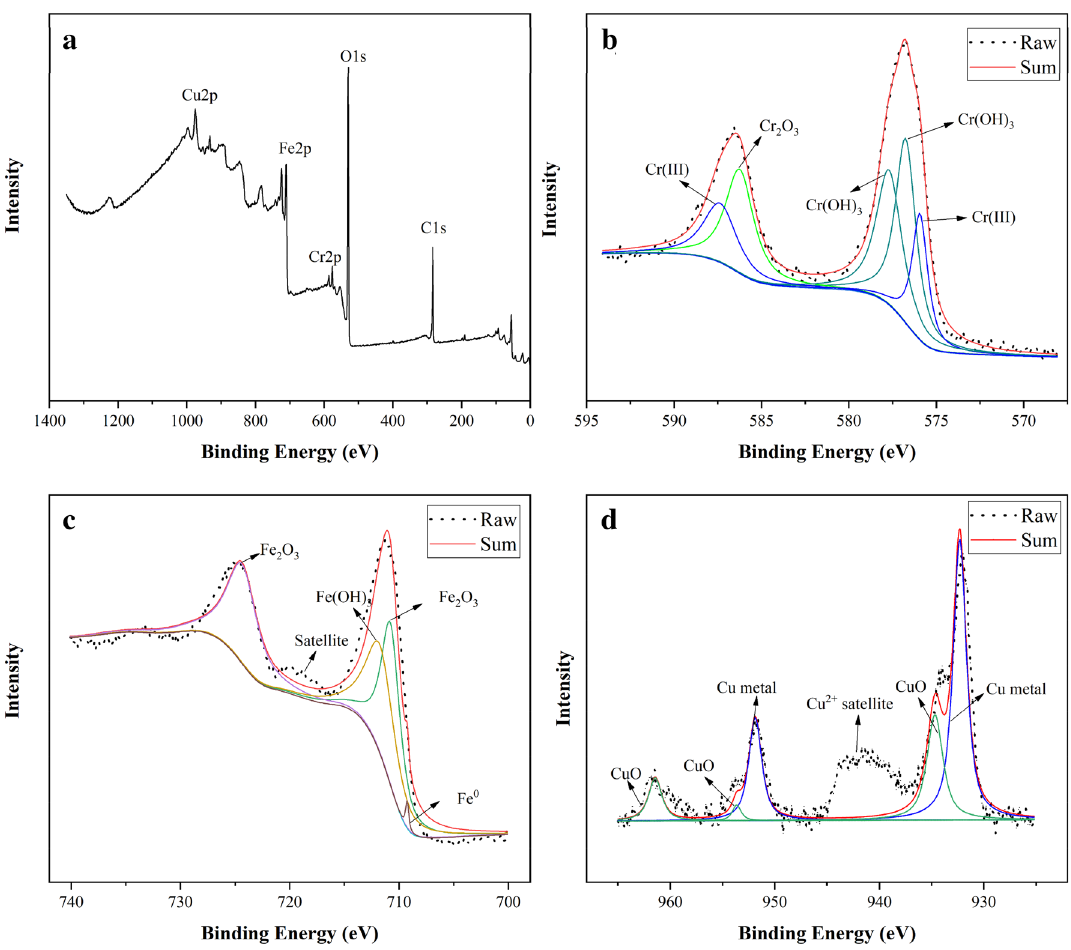
Figure 7. XPS spectra of Cu/Fe bimetallic nanoparticles after removal reaction with Cr(VI): ( a ) wide scan, ( b ) Cr 2p spectrum, ( c ) Fe 2p spectrum, ( d ) Cu 2p